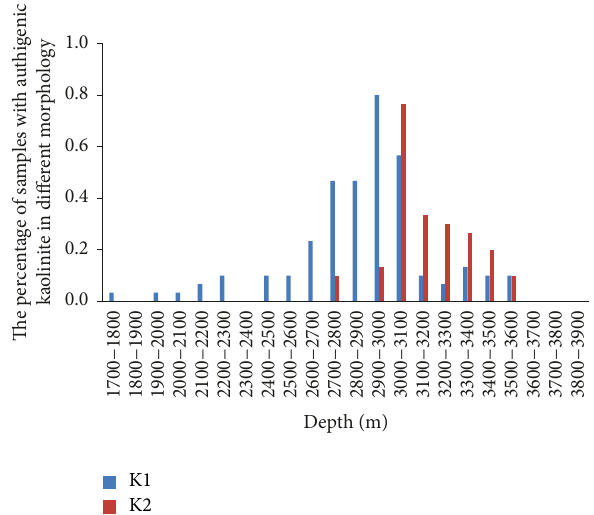
Figure 14: The distribution of authigenic kaolinites with different morphologies in Es sandstone of Dongying Sag